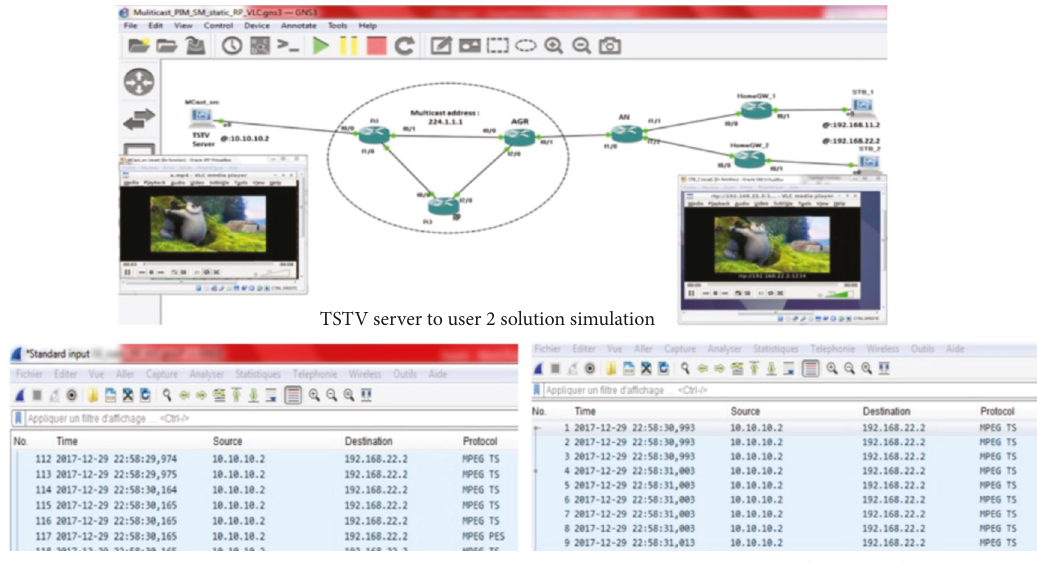
Figure 13: TSTV server to user 2 solution simulation content preview and traces.